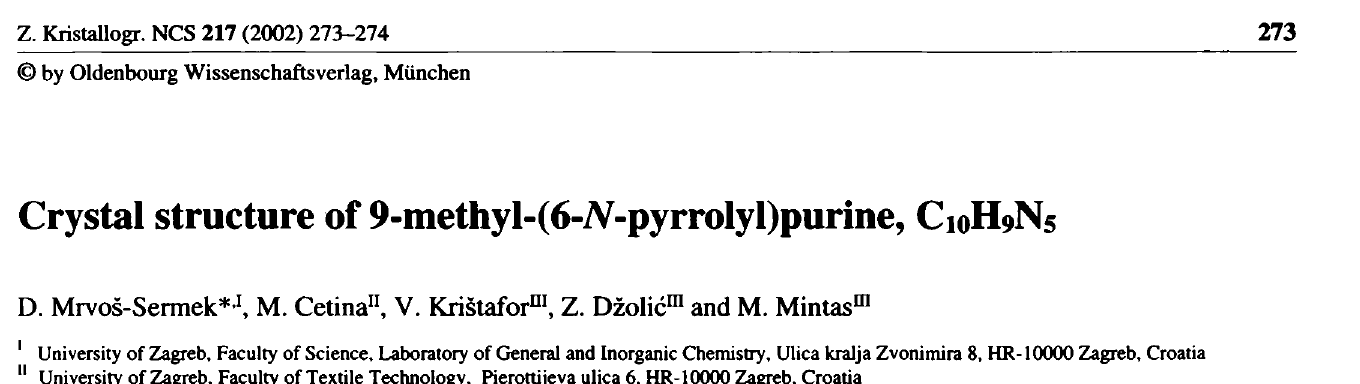
Table 1. Data collection and handling.